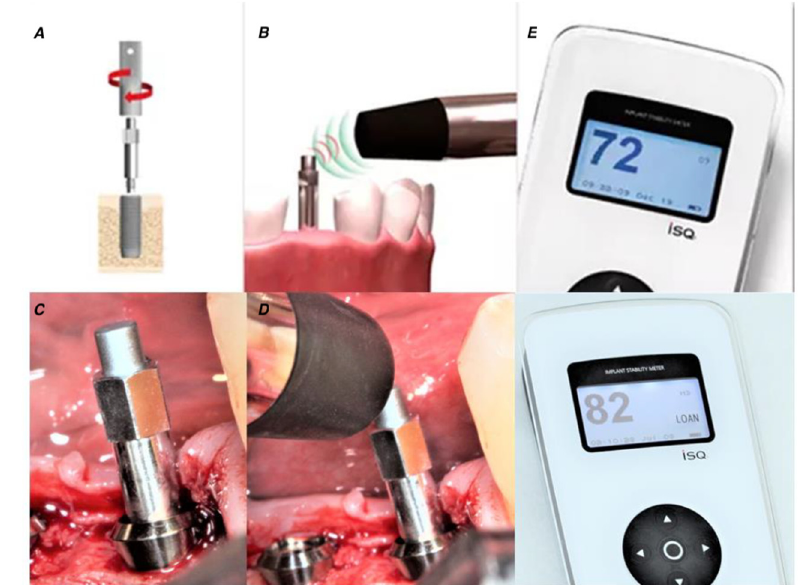
Figure 1. Illustration of the resonance frequency analysis (RFA): ( A ) insertion of the measurement adapter, ( b ) resonance frequencies measured with the device, ( C ) implant with adapter in situ, ( D ) RFA-measurement from the vestibular side, and ( E ) implant stability meter with implant stability quotient (ISQ) values for the evaluation.